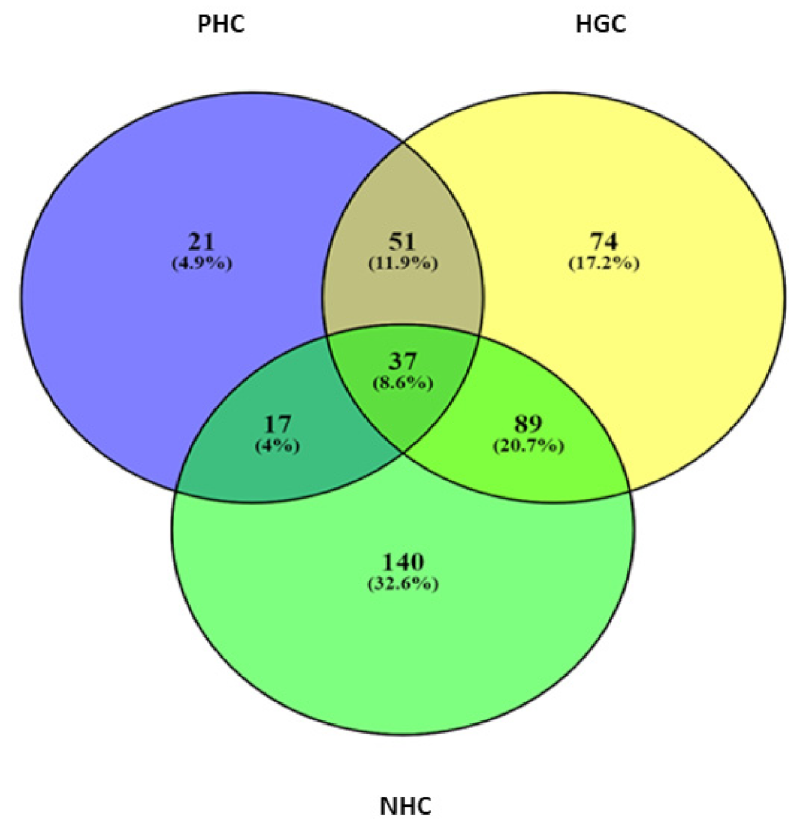
Figure 4. Venn diagram illustrating the proportions of unique and common bacterial genera noticed among the three